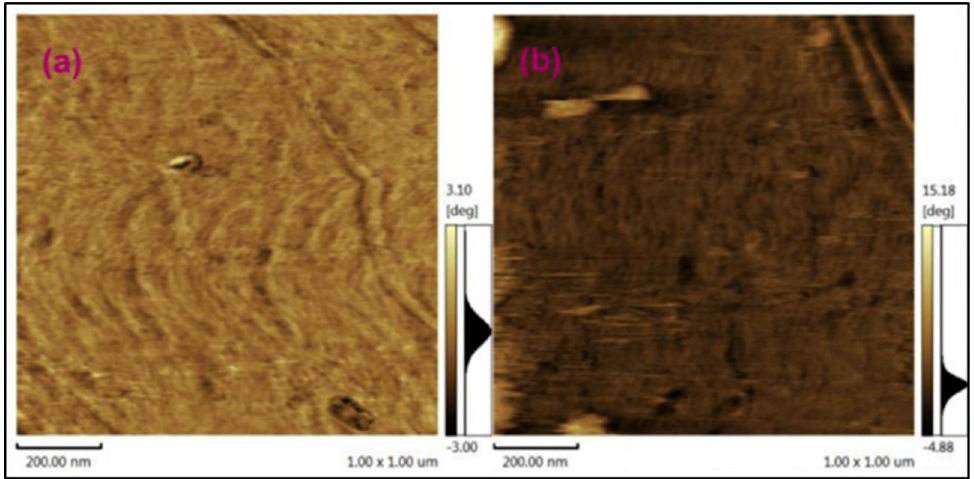
Figure 19. AFM phase images for ( a ) pristine SPEEK, and ( b ) SPEEK-SCNF (1 wt.%) membranes. Reproduced with permission from [78], with permission from Elsevier, 2017.